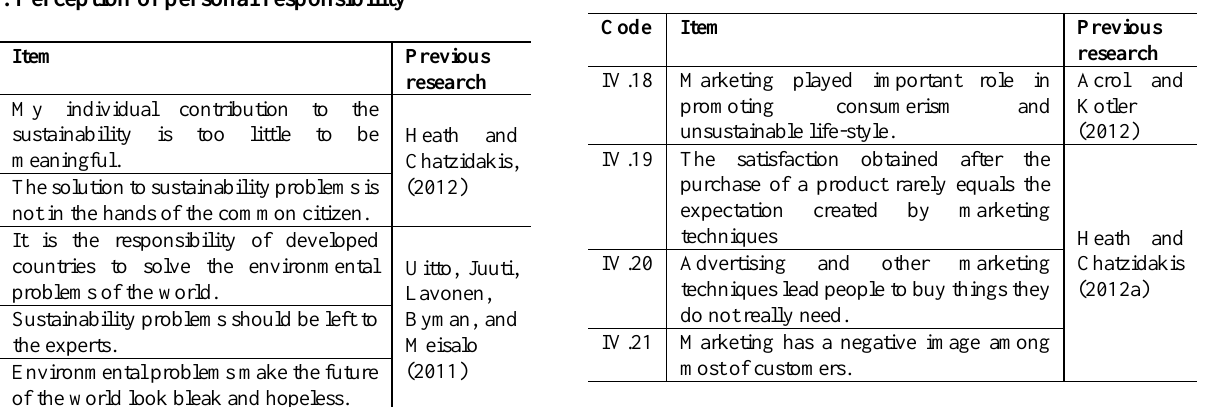
Table 4: Perception of marketing’s role in driving consumerism and unsustainable consumer